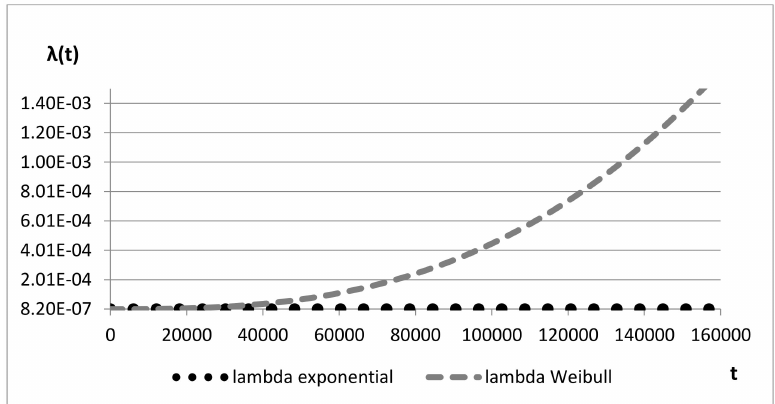
Figure 5. Comparison of failure rate λ ( t ) for Prj1.